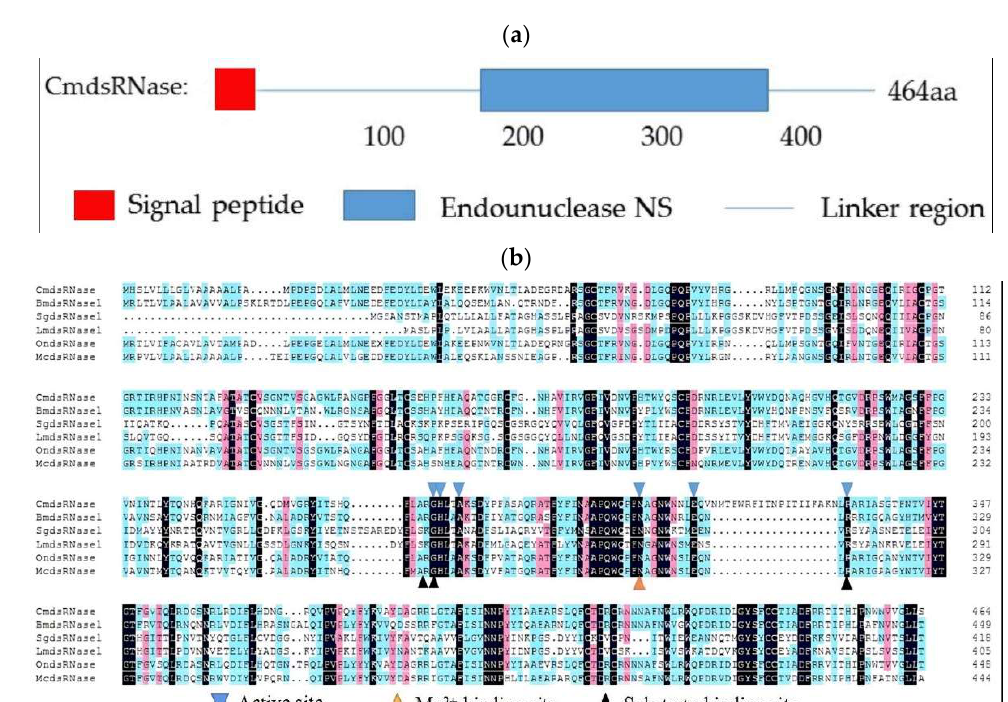
Figure 1. Nucleotide and deduced amino acid sequences of CmdsRNase ( dsRNase from C. medinalis ). The asterisk indicates the stop codon, and the target sequence of RNAi is marked in green (585–1012 bp).